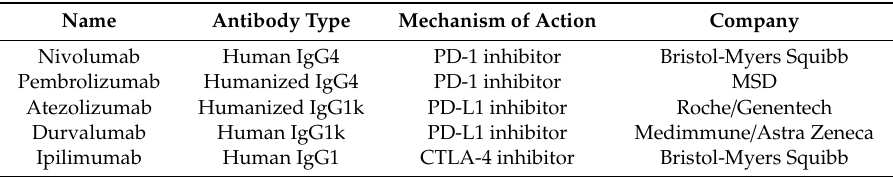
Table 1. Characteristics of Immune Checkpoints Inhibitors discussed in the